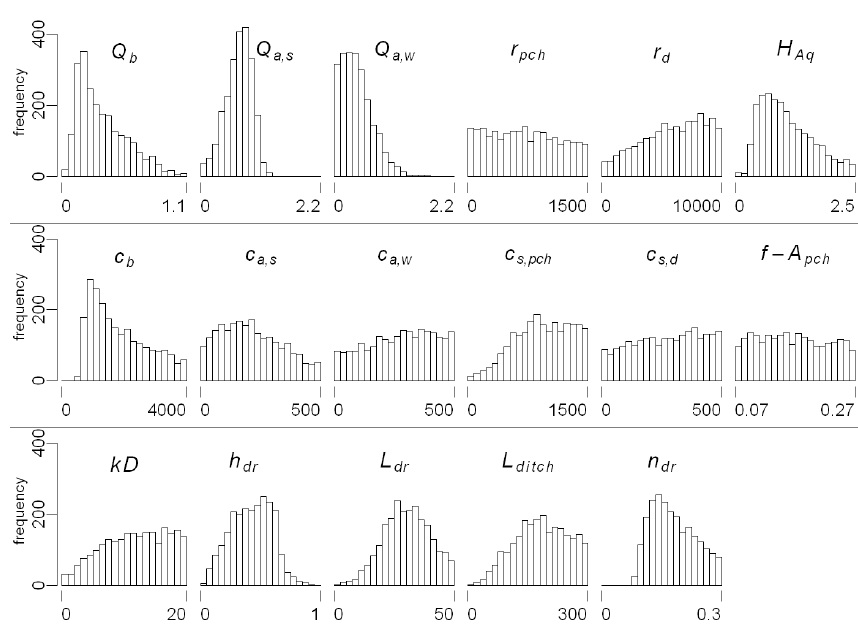
Fig. 5. Posterior behavioural parameter distributions for GLUE analysis GA-B. Units of parameter values are listed in Table 2.